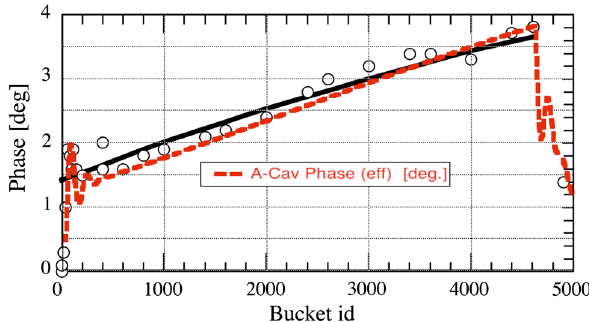
FIG. 6. Comparison of the result of the new simulation for LER (dashed red line) with the observed data (dots) and the previous simulation (solid black line). The observed data and the previous simulation are replotted from Fig. 2(a).